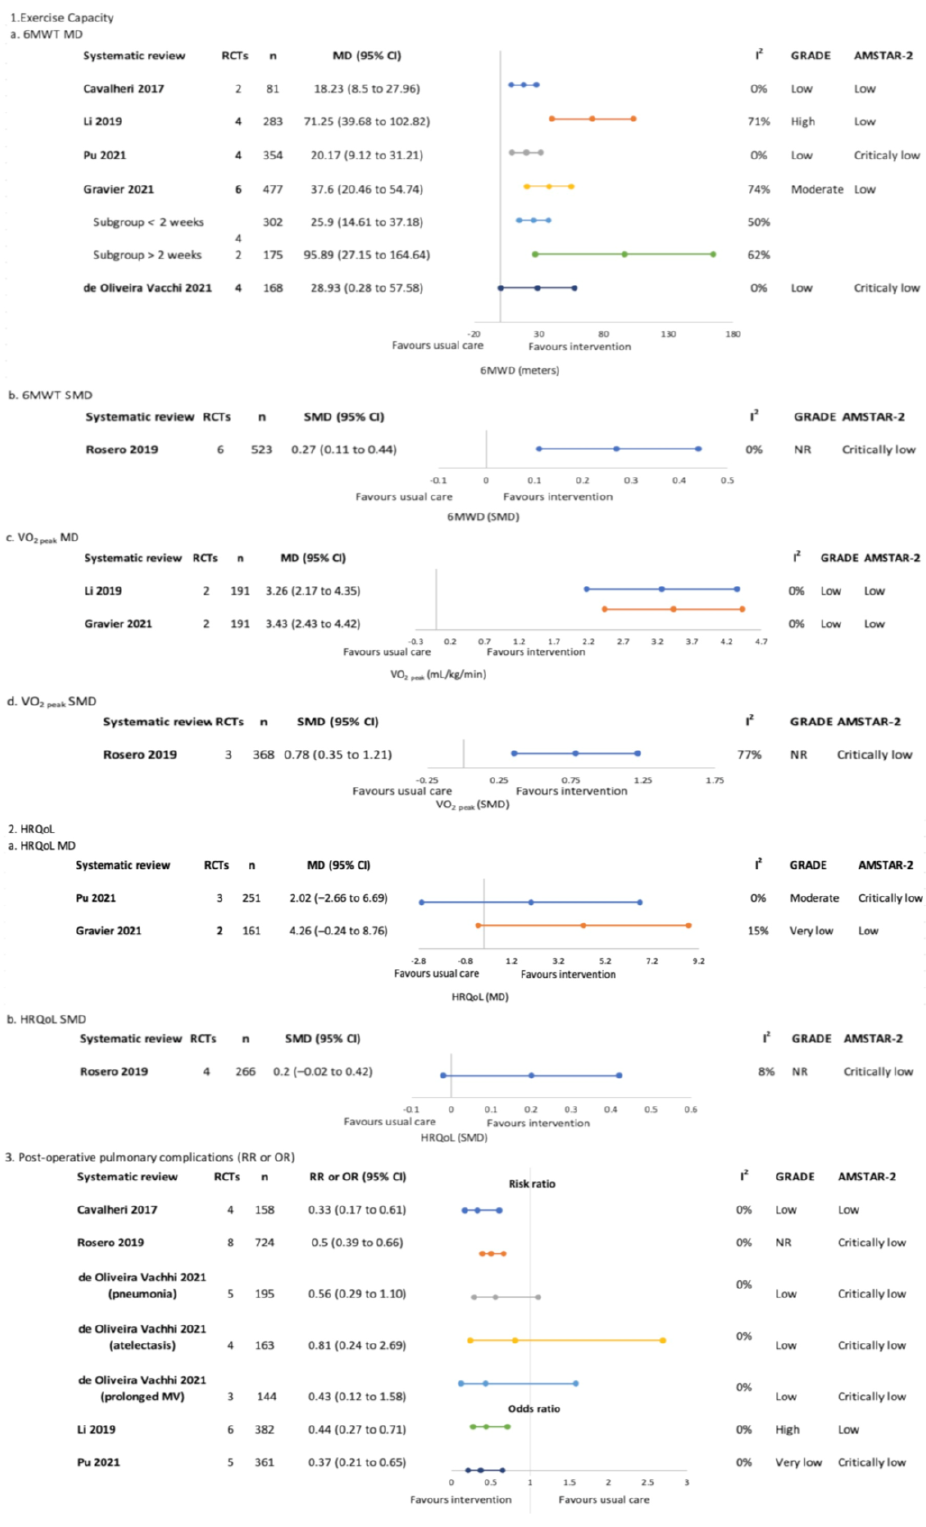
Figure 3. Pre-treatment only (surgical)–meta-analysis findings for overview primary outcomes (1. Exercise capacity, 2. HRQoL and 3. Post-operative pulmonary complications)